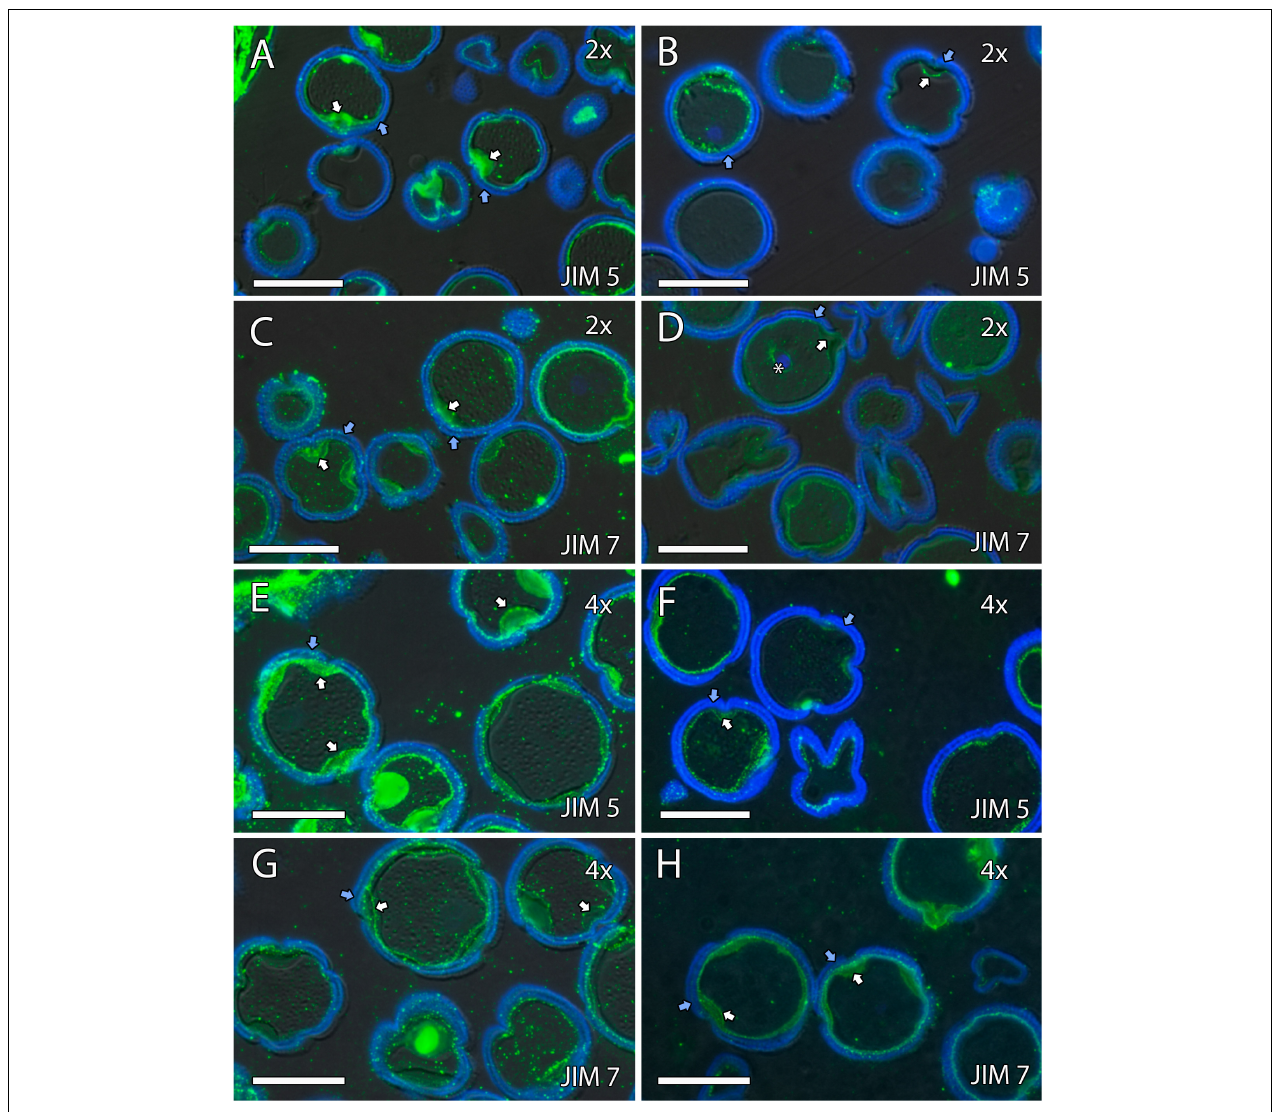
FIGURE 7 | Immunolocalization of pectins during microgametogenesis in diploid and doubled diploid “Sanguinelli” blood orange. Monoclonal antibodies used: (A,B,E,F) JIM5 against pectins and (C,D,G,H) JIM7 against methyl-esterified pectins. (A,C,E,G) JIM5 (A,E) and JIM7 (C,G) labeling (pectins) was observed in the aperture sites (white arrows) and in the intine after mitosis I and vacuolization. Similar JIM5 (B,F) and JIM7 (D,H) labeling was observed in the intine and wall of the generative nucleus (asterisk in D ) of pollen grains at anther dehiscence. The exine was observed in blue (autofluorescence, blue arrows). All scale bars = 25 mm. Tapetum (t), diploid (2x), and doubled diploid